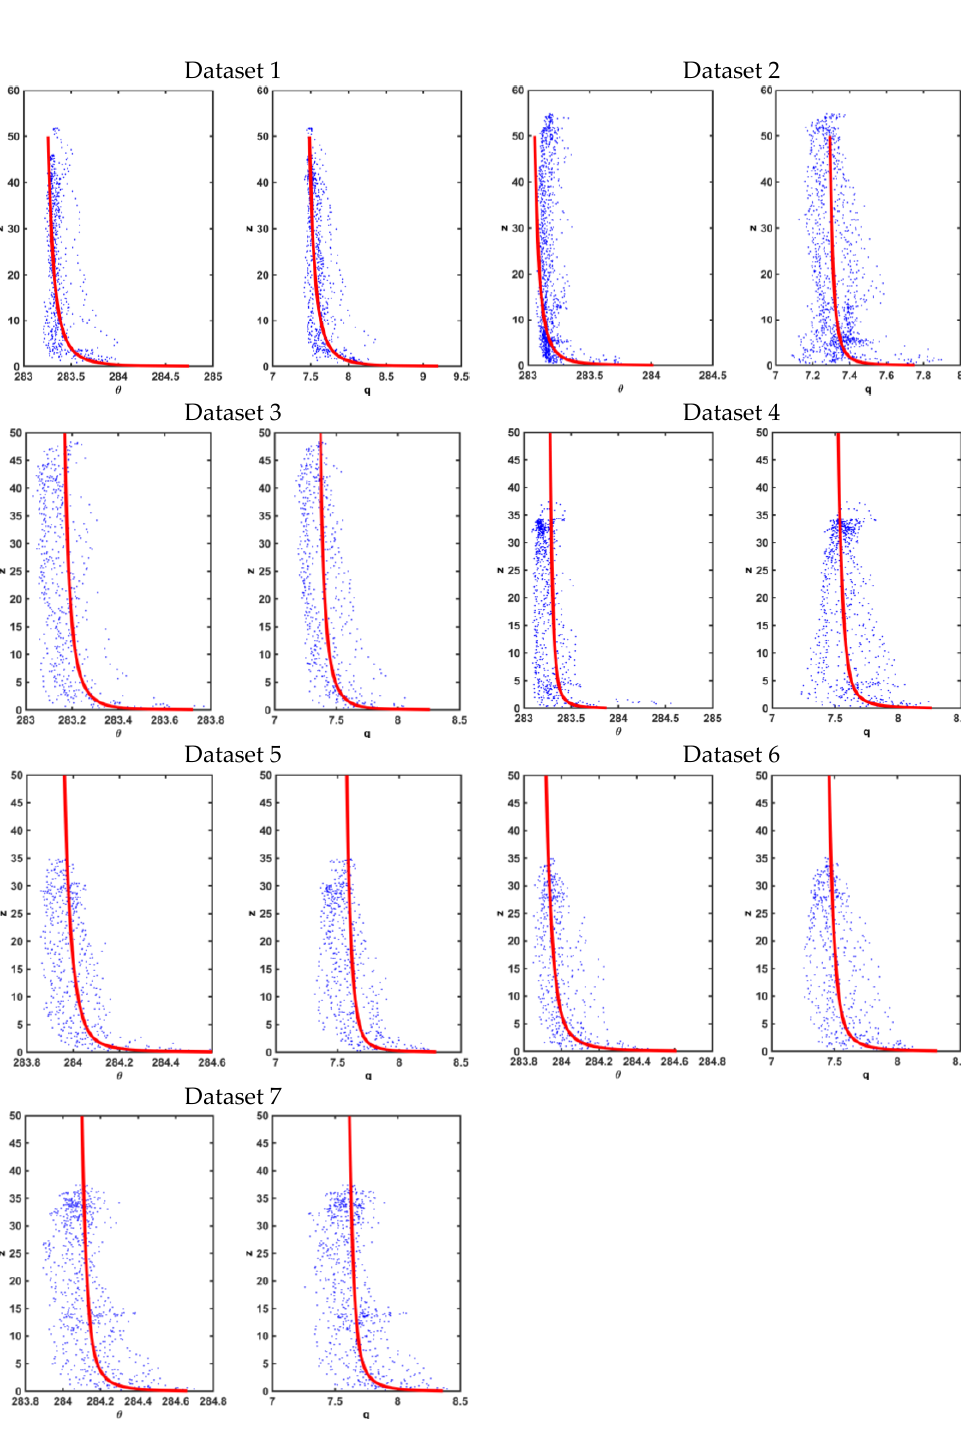
Figure 3. The mean potential temperature and specific humidity profiles estimated with the optimization method (red solid lines) and the original sampled data (blue dots). The vertical axes are height from the surface in meters. The units for θ and 𝑞 are Kelvin and g·kg −1 , respectively.